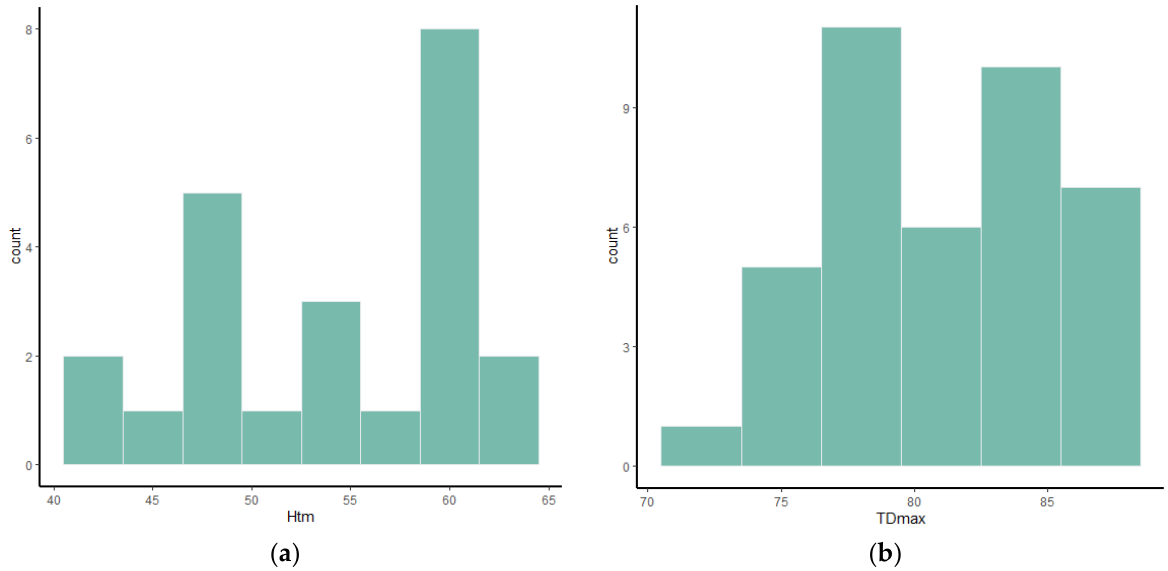
Figure 3. ( a ) Frequency distribution of the height of the trochlea’s medial lip (HTm) and ( b ) the maximum transverse diameter in the astragalus of S. etruscus.